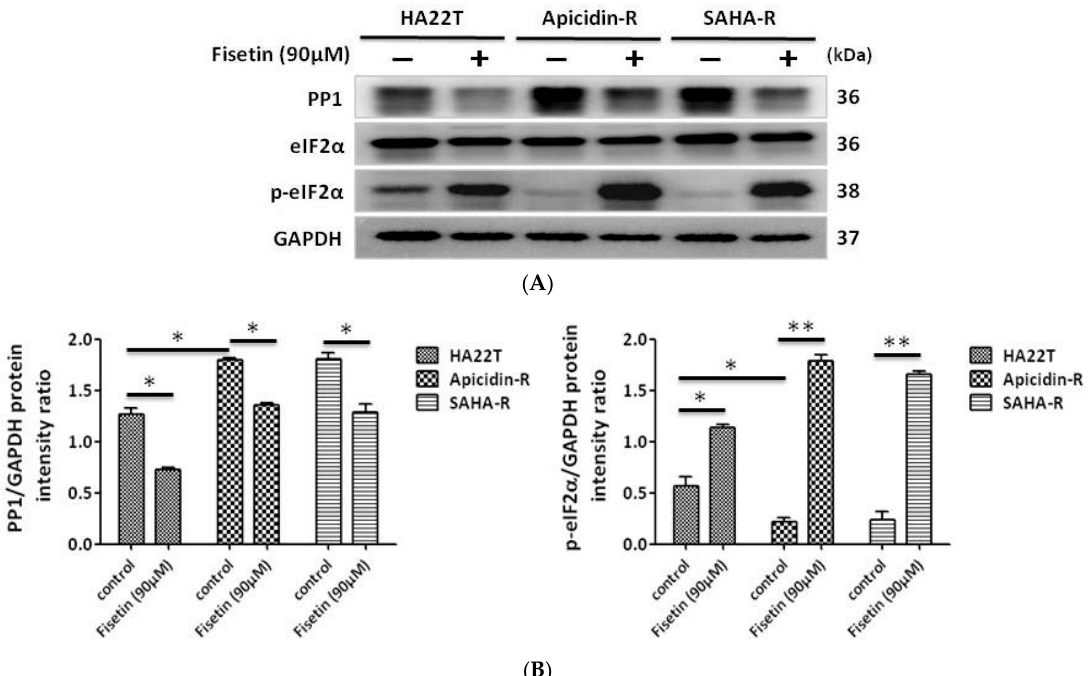
Figure 4. Fisetin-induced eIF- 2α phosphorylation in HCC cells via the inhibition of the protein phosphatase 1 (PP1)- mediated regulatory system for eIF2α phosphorylation. HA22T, apicidin -R, and SAHA-R cells were treated with fisetin (90 μM) for 24 h. ( A ) p- eIF2α levels were increased and PP1 expression was decreased in HCC cells upon fisetin treatment. Interestingly, increased PP1 protein expression was noted in apicidin-R and SAHA-R cells compared with HA22T in normal conditions. ( B ) In Fig. 4A, all protein samples were analyzed by western blotting. The protein expression was normalized to GAPDH. * p < 0.05, ** p < 0.01, *** p < 0.001 compared with the control group.